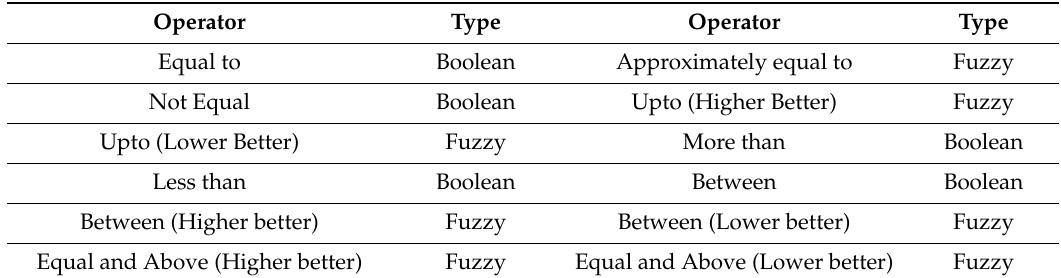
Table 4. Operators used for quantifying numeric property